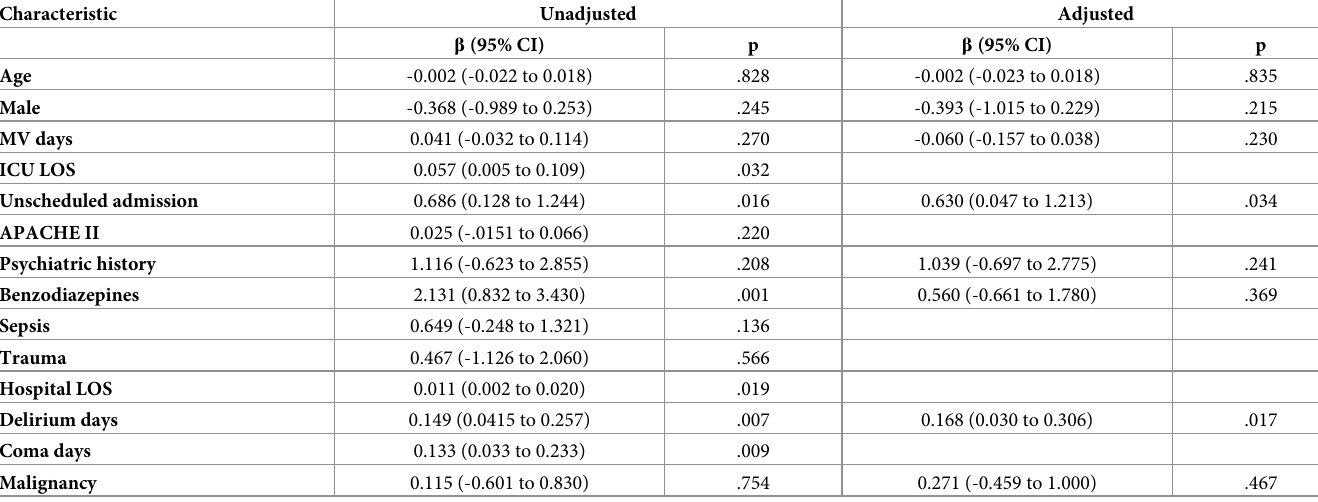
Table 4. Risk factors for the severity of depressive symptoms a in the univariable and multivariable analyses using a multilevel linear regression model.